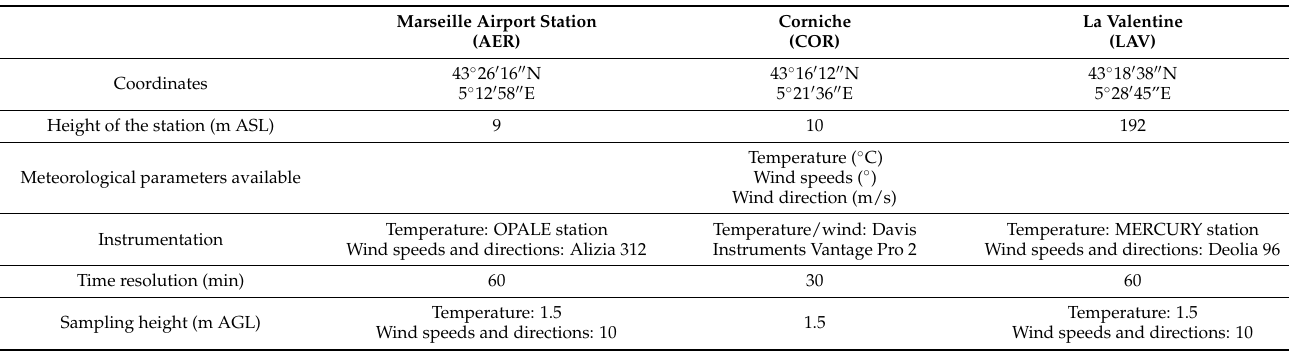
Table 2. Meteorological instrumentation and parameters